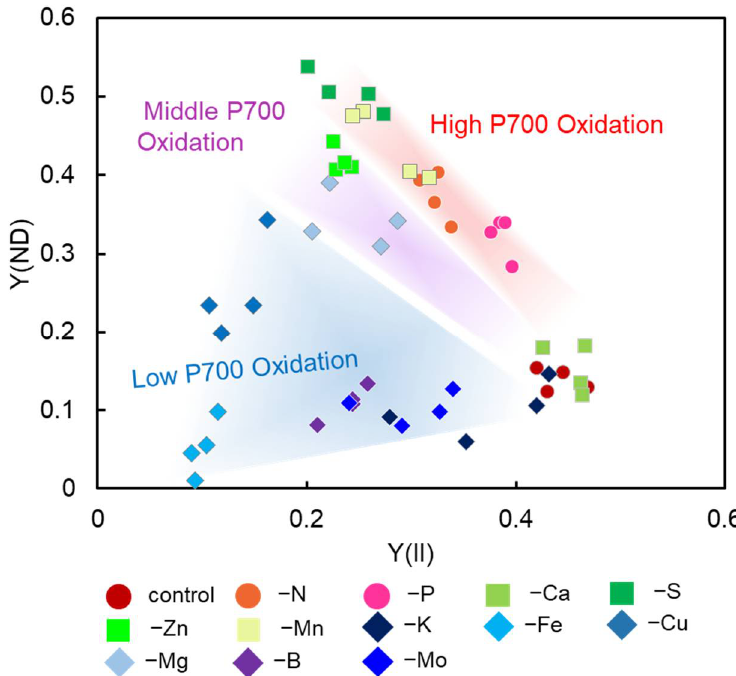
Figure 2. Relationships between Y(ND) and Y(II). The data were from the induction analysis of photosynthesis parameters, as shown in Figure 1, and the steady-state values of both Y(II) and Y(ND) were plotted. Sunflower plants ( Helianthus annuus ) were grown under the nutrient-deficiency conditions, as follows. Circles: red, control; orange, nitrogen deficiency (–N); pink, phosphate deficiency (–P). Diamonds: dark blue, potassium deficiency (–K); blue, iron deficiency (–Fe); purple, copper deficiency (–Cu); pale blue, magnesium deficiency (–Mg); dark purple, boron deficiency (–B); medium purple, molybdenum deficiency (–Mo); pale green, calcium deficiency (–Ca); dark green, sulfur deficiency (–S); green, zinc deficiency (–Zn); pale-green, manganese deficiency (–Mn). Sunflower plants ( Helianthus annuus ) were grown in the fields, as follows. Responses of Y(ND) against Y(II) were divided into three types: High P700 Oxidation, Middle P700 Oxidation, and Low P700 Oxidation. Please see the details in the text for more information (in the subsection of “Steady-state analysis of P700 oxidation”).